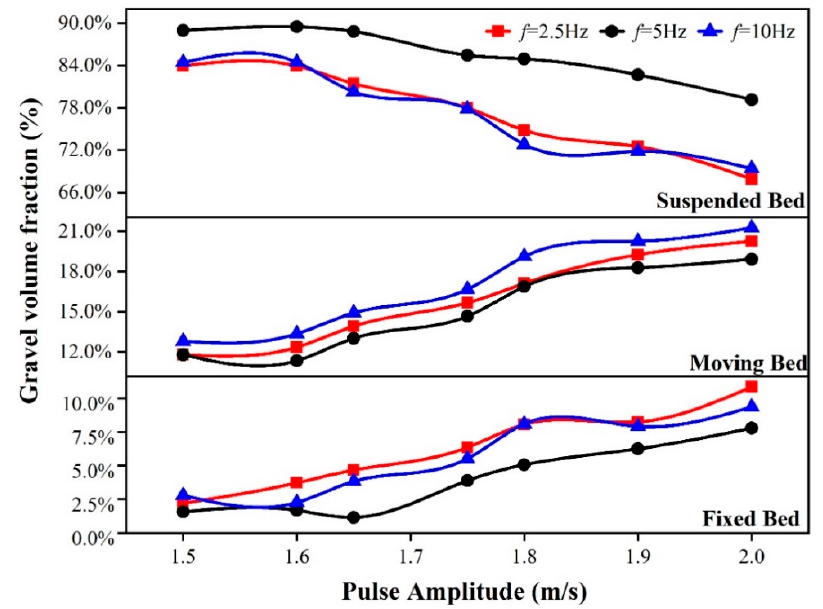
Figure 6. Graph of gravel volume fraction for pulsed gravel packing in horizontal wells.